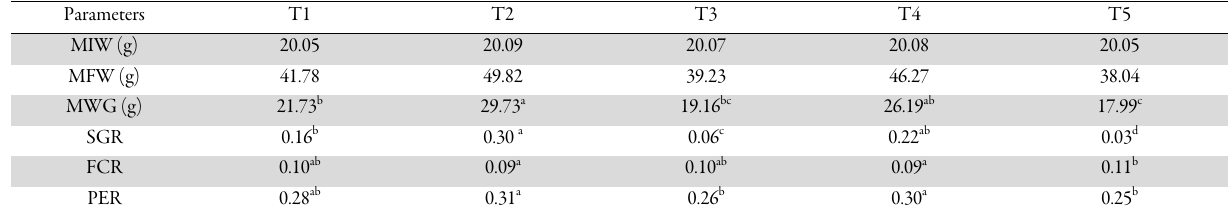
Mean with the same superscript are not significantly different Table 9. Nutrient utilization of diets fed Clarias gariepinus